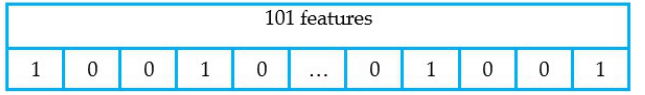
Figure 6. Definition of a chimp in the MOBChOA algorithm.